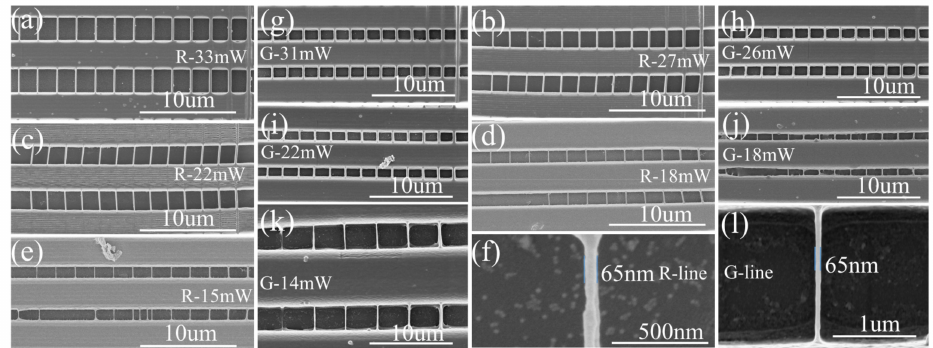
Figure 3. FE-SEM images illustrating the morphologies of the DLW processed 5 mg/mL red QD–polymer suspended lines ( a – e ): ( a ) 33 mW; ( b ) 27 mW; ( c ) 22 mW; ( d ) 18 mW; ( e ) 15 mw; and 5 mg/mL green QD–polymer suspended lines ( g – k ): ( g ) 31 mW; ( h ) 26 mW; ( i ) 22 mW; ( j ) 18 mW; ( k ) 14 mw, and SEM image of the smallest suspended line of the DLW processed red QD–polymer composites ( f ) and green QD–polymer composites ( l ). R stands for red QD–polymer and G stands for green QD–polymer in the figure. For each laser power, the suspended lines from right to left were fabricated using v from 100 to 700 µ m/s with an interval of 50 µ m/s.